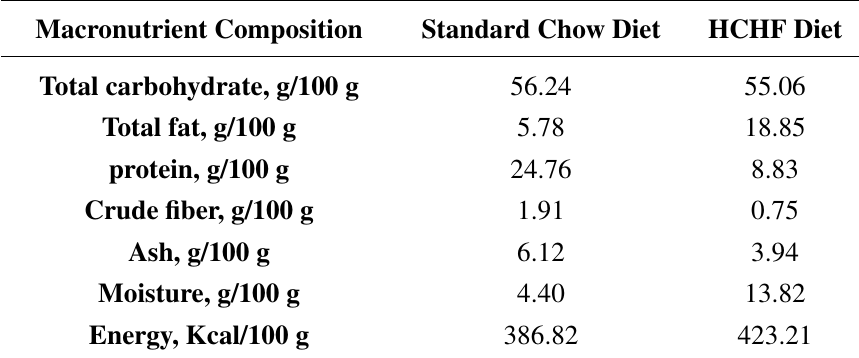
Table 1. Energy densities in the food pellets of control and MS groups.